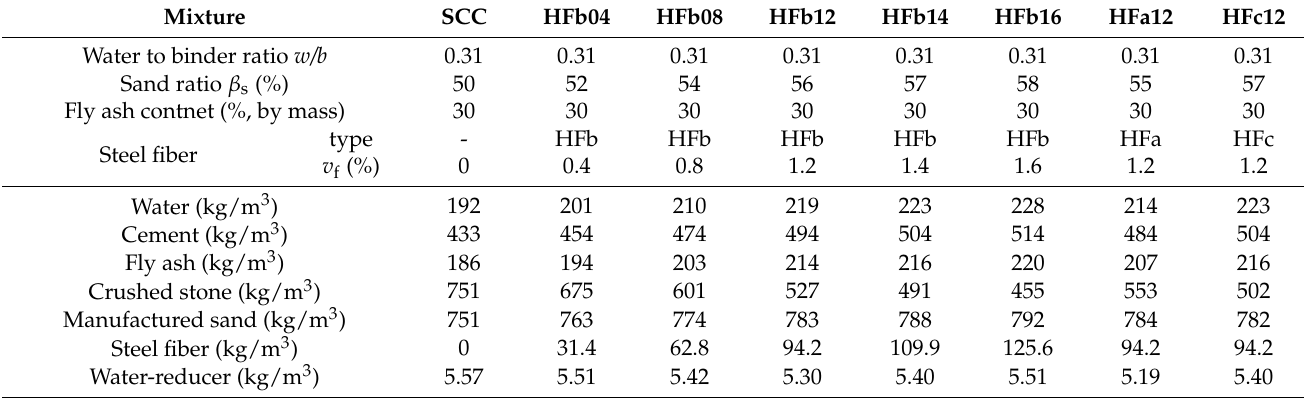
Table 3. Mix proportion of self-compacting SFRC by using the direct mix design